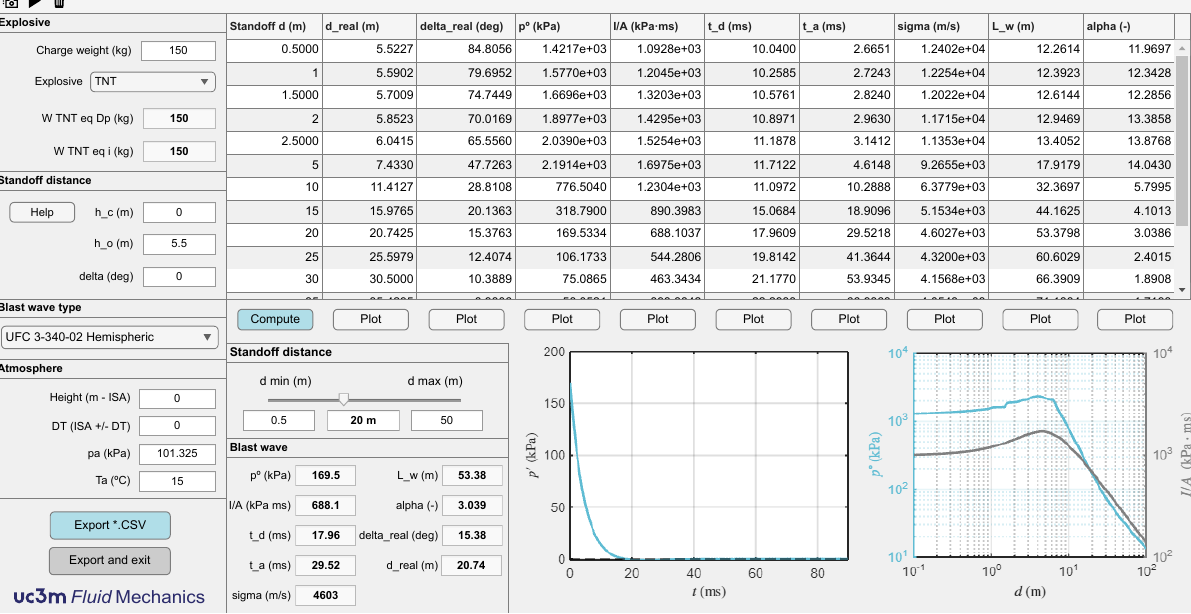
Figure 10. Interface of the Blast Wave calculation assistant for a charge weight of 150 kg of TNT at the ISA mean sea level, showing the variation of the blast parameters with the standoff distance from the front façade (top table). The lower part of the assistant shows the blast parameters calculated at a point located at d = 20 m standoff distance and h 0 = 5.5 m above the